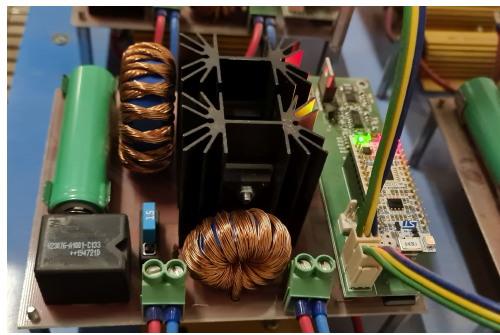
Figure 5. Developed device for cycling battery cell testing.